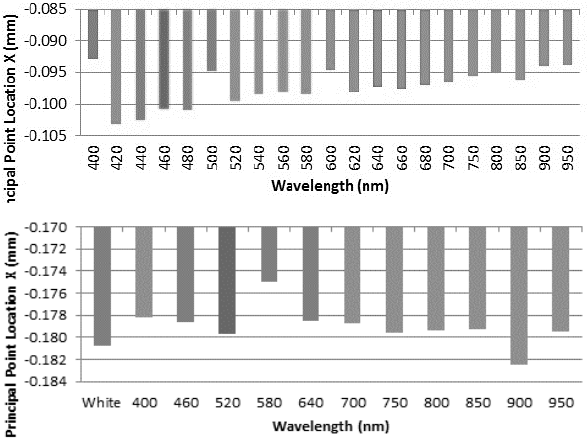
Figure 8. Variation in Principal Point (X) with Wavelength. Principal point variations show a clear difference between the two sensors with offsets varying by some 26 pixels in the X direction and 22 pixels in the Y direction (Fig. 8 top and Fig. 9 top). However in all cases the uncertainty (standard deviation) of the estimated parameters is of the order of 0.006mm (about 3 pixels), which for Dataset2 with its additional roll angle imagery, encompasses the majority of the estimated parameter spread. Principal point, corresponding to the optical axis in an ideal lens would not be expected to be affected by variations in refraction.